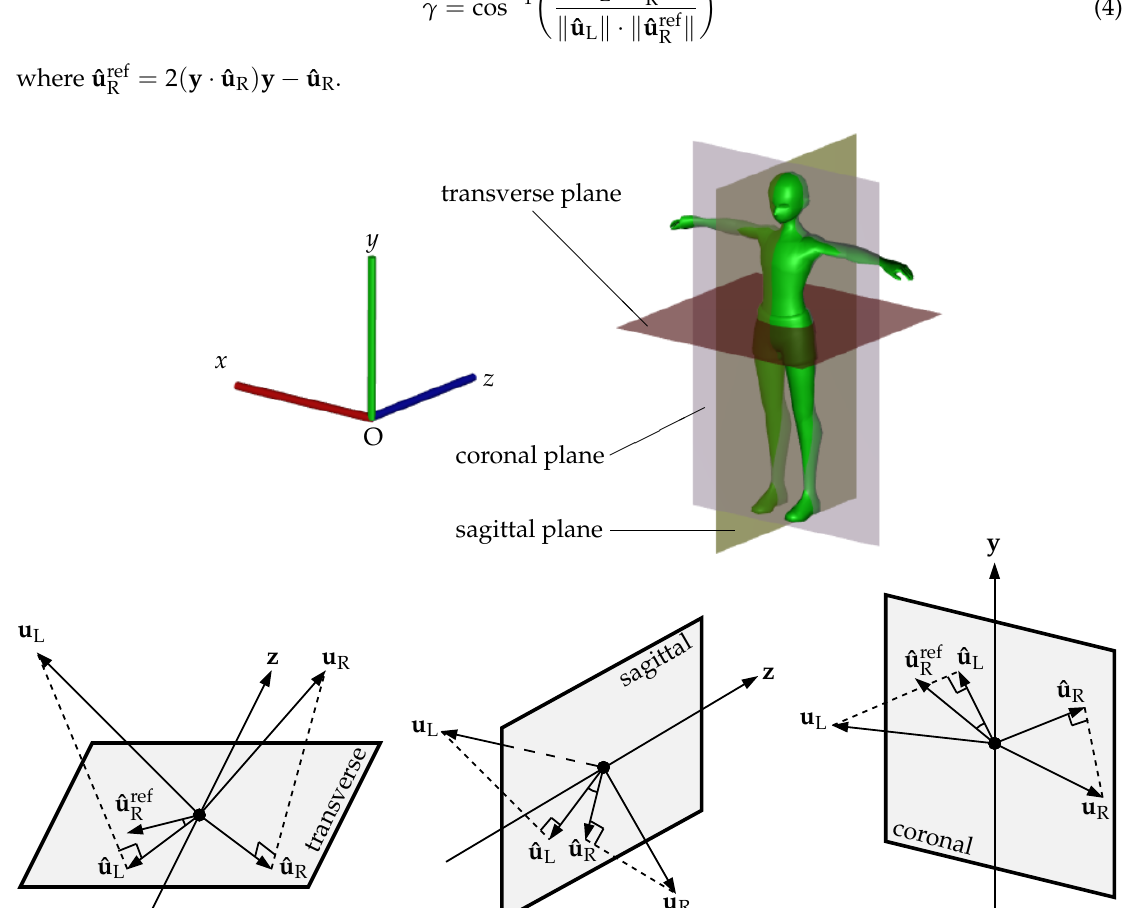
Figure 4. ( Top ) 3D representation of a body and the three anatomy planes together with the camera coordinate system. ( Bottom ) angle estimation based on transverse, sagittal and coronal